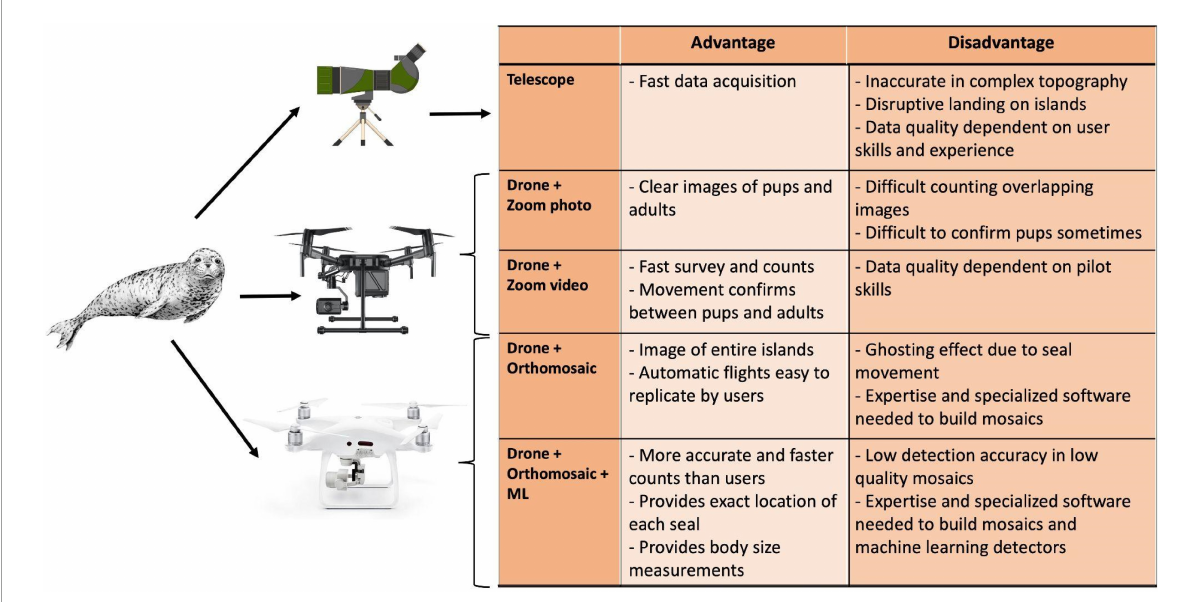
FIGURE7 Summary of the advantages and disadvantages for each sampling method to count seal pups by telescope, drone with a photo/video zoom, orthomosaics and machine learning (ML).